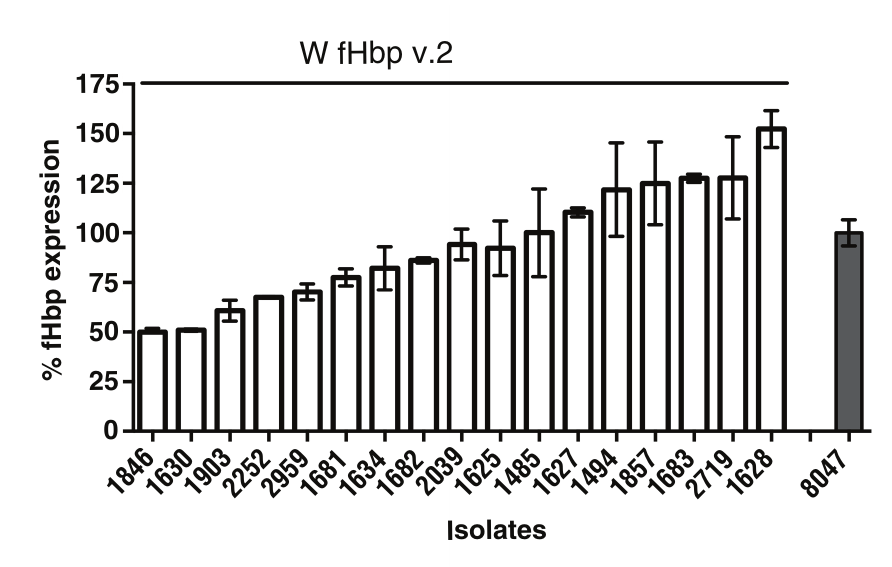
Figure 2. Expression of fHbp in meningococcal serogroup W isolates from Ghana and Burkina Faso, assessed by Western blotting. Bars represent the mean percentage from three biological replicates compared with the expression of fHbp of the reference group B strain 8047, a high expresser of fHbp variant 2 ID 77, which was set at 100%. Isolates with means below 33% were classified as low expressers while isolates with expression above 100% were categorized as high expressers. Values between 33–100% were considered as intermediate expression. Bars represent standard